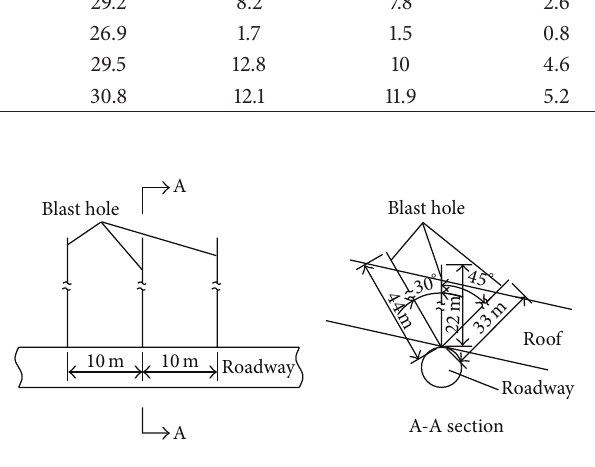
Figure 3: The schematic diagrams of